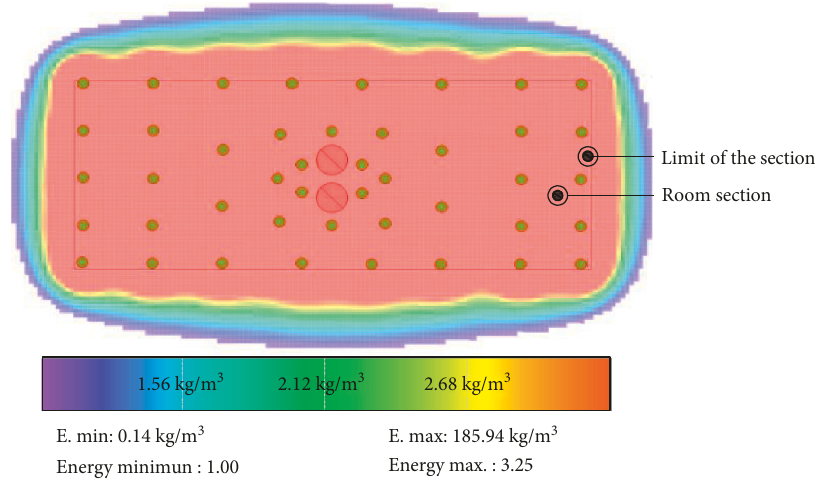
Figure 7: Energy released after sequential detonation (4.01m